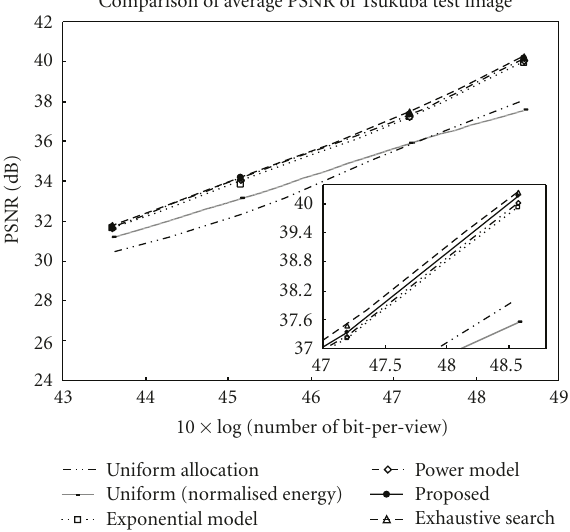
Figure 7: PSNR comparison of Tsukuba test image when using di ff erent bit allocation methods.